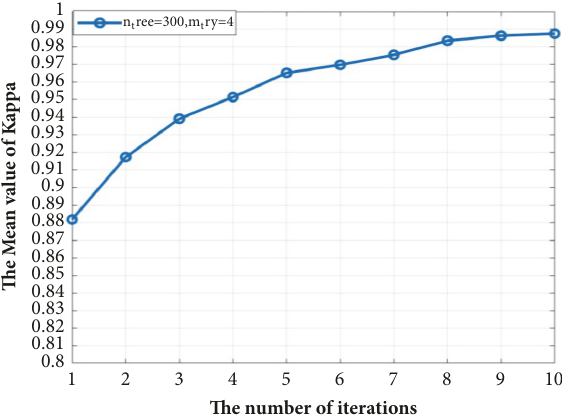
Figure 31: Classification kappa trend of different initial and iterative condition of Hyperion data for method 1.